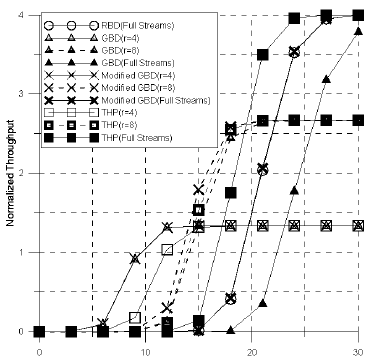
Figure 7. The throughput comparison when each of the 4 UEs has 3 receive antennas and the BS has 16 transmit